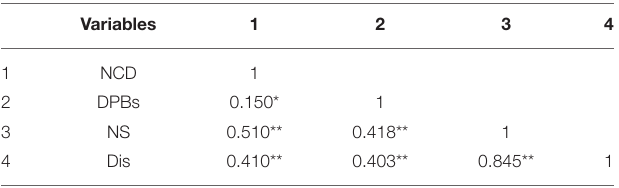
TABLE 4 | Pearson correlations between neurocognitive deficits, dysfunctional performance believe, negative symptoms, and disability ( n =